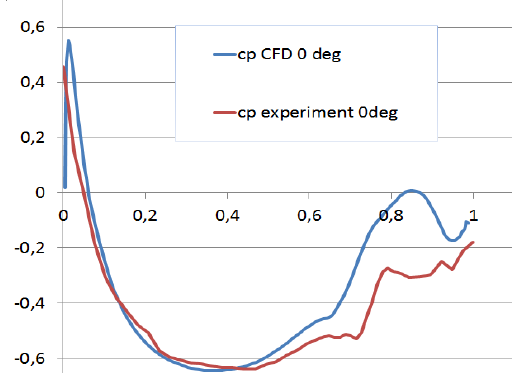
Fig. 5. Lift coefficient c PL distribution along the chord of the AH93-157 airfoil.